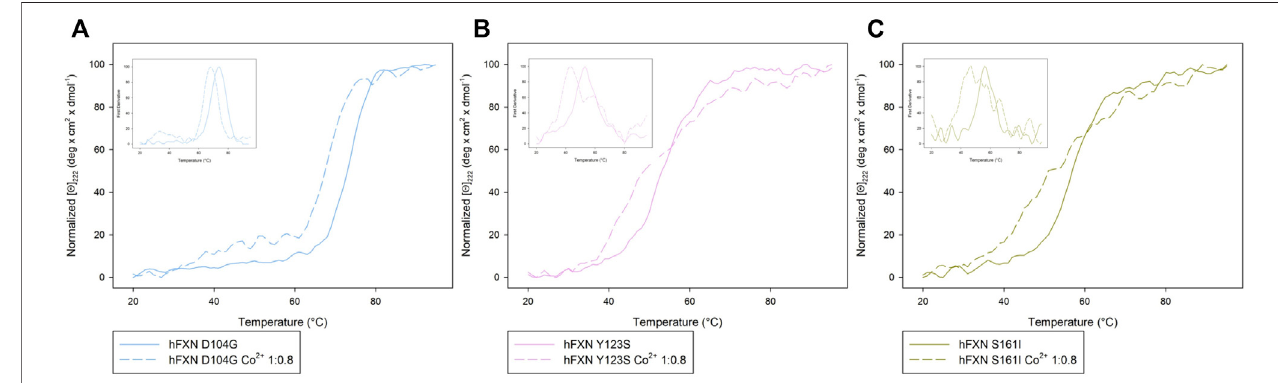
FIGURE 5 | Comparison of the Near-UV CD data of [ Θ ] 222 as a function of the temperature of the D104G (light blue), Y123S (light pink), and S161I (dark yellow) variants (A – C) in the absence of Co 2+ (continuous curves) and in the presence of 0.8 Co 2+ equiv (dotted lines). The insets show the fi rst derivative of the experimental curve with respect to temperature.